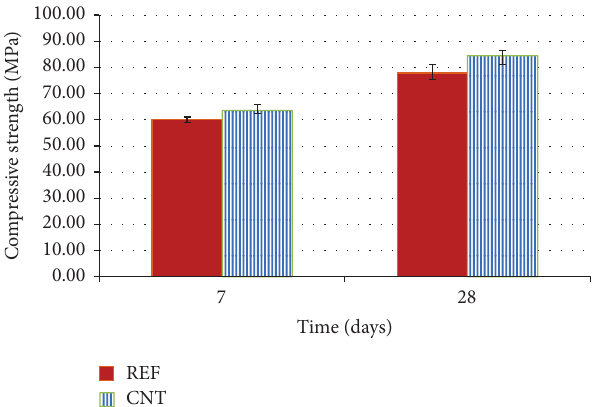
Figure 6: Compressive strength of cement mortars with and without CNT after 7 and 28 days. There is obvious increase in mortars’ strength with CNT’s addition.